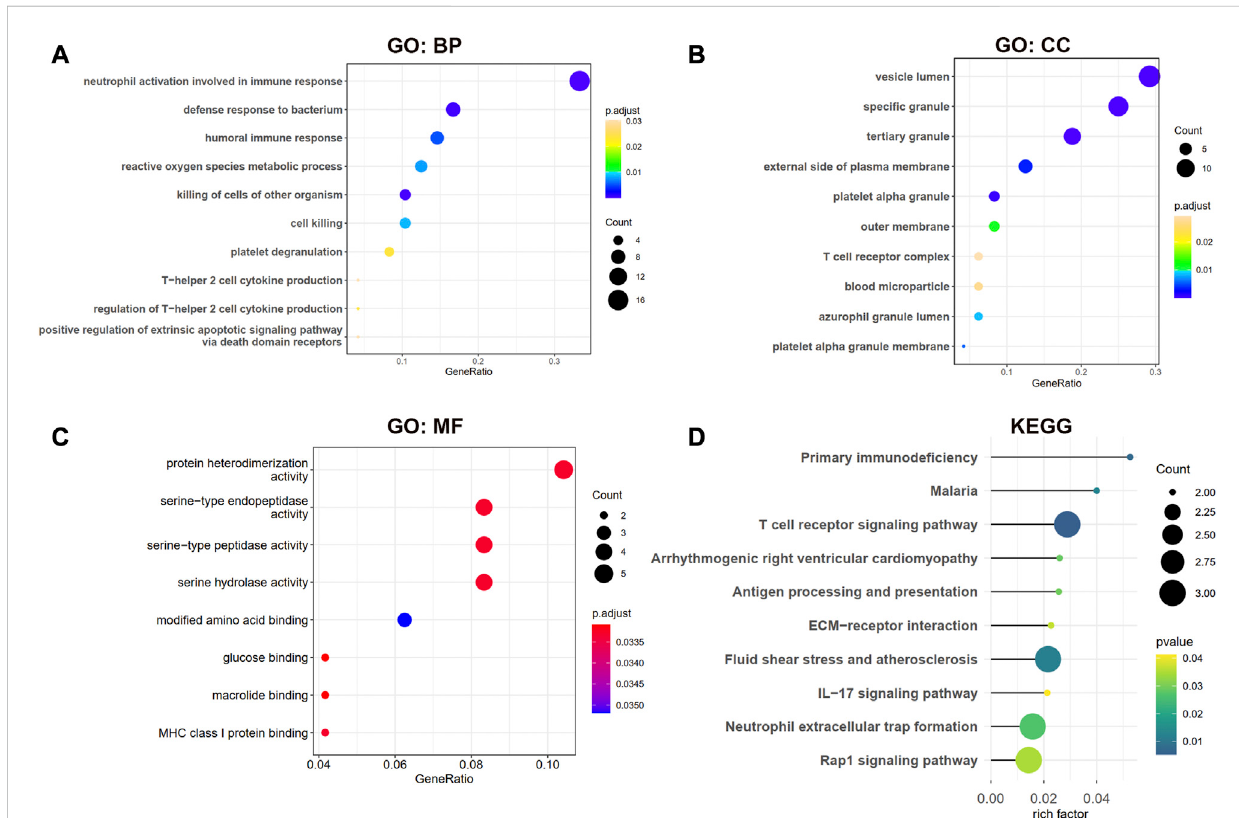
FIGURE 4 GO and KEGG enrichment analysis for shared DEGs between MDD and IS. (A – C) BP, CC, and MF of GO analysis were enriched for common DEGs. (D) KEGG pathways of common DEGs. BP, biological processes; CC, cellular components; MF, and molecular